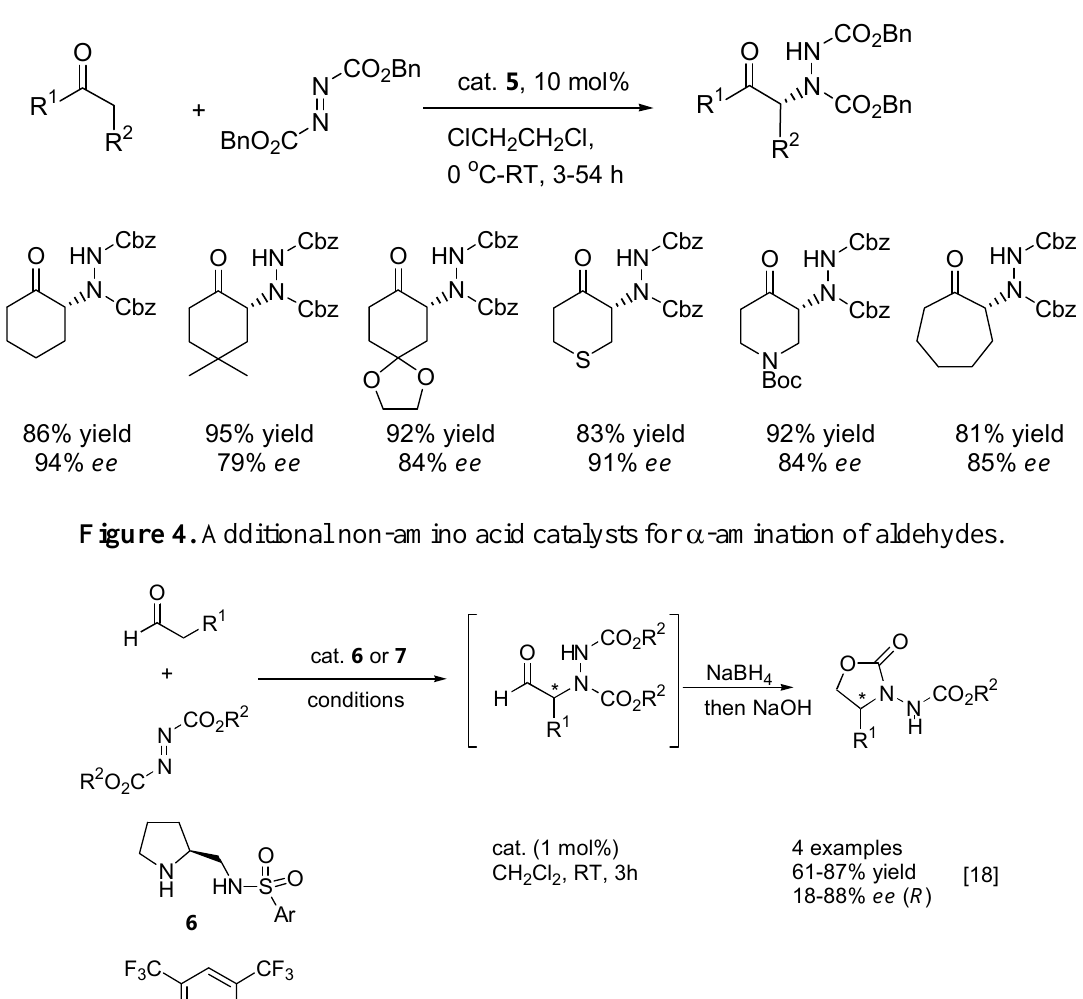
Figure 3. Examples of products from  -amination of cyclic ketones catalyzed by the silyloxyproline 5 [29].